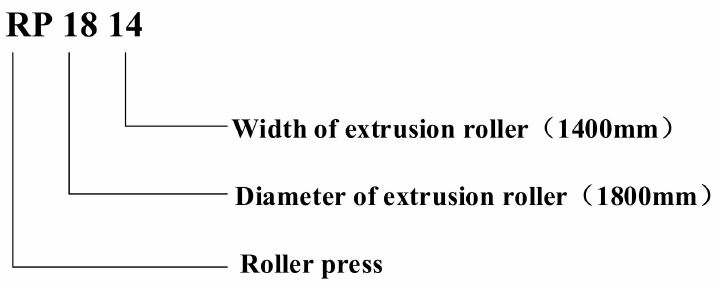
Figure 1. Model description of RP1814 roller